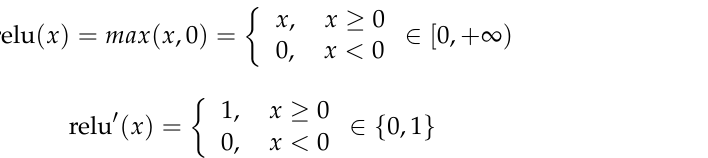
Figure 4. Neural Network Prediction Model.